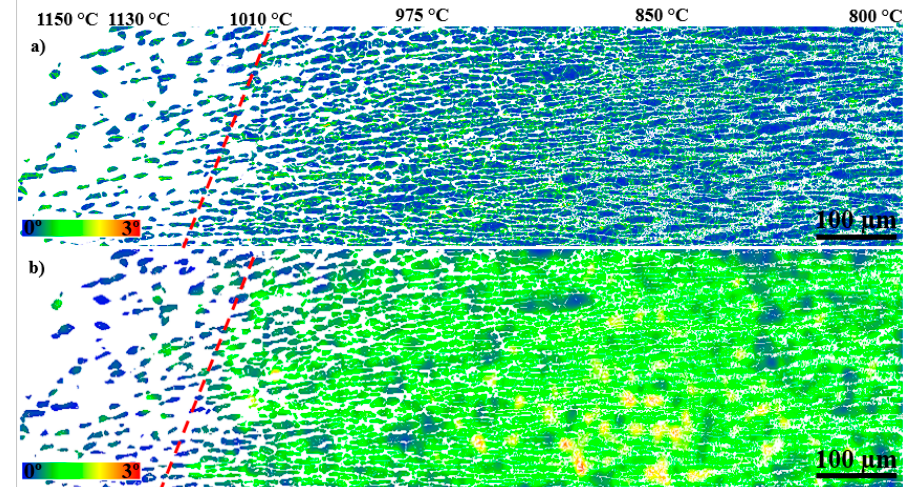
Figure 7. ( a ) A low-resolution austenite local misorientation ( γ -LMO) map showing the highest local misorientation in the region where blocky σ precipitated; ( b ) EBSD-estimated “strain” distribution map for austenite. The broken line shows 1010 °C isotherm lines, where σ started precipitating. Materials 2018 , 11 , x FOR PEER REVIEW